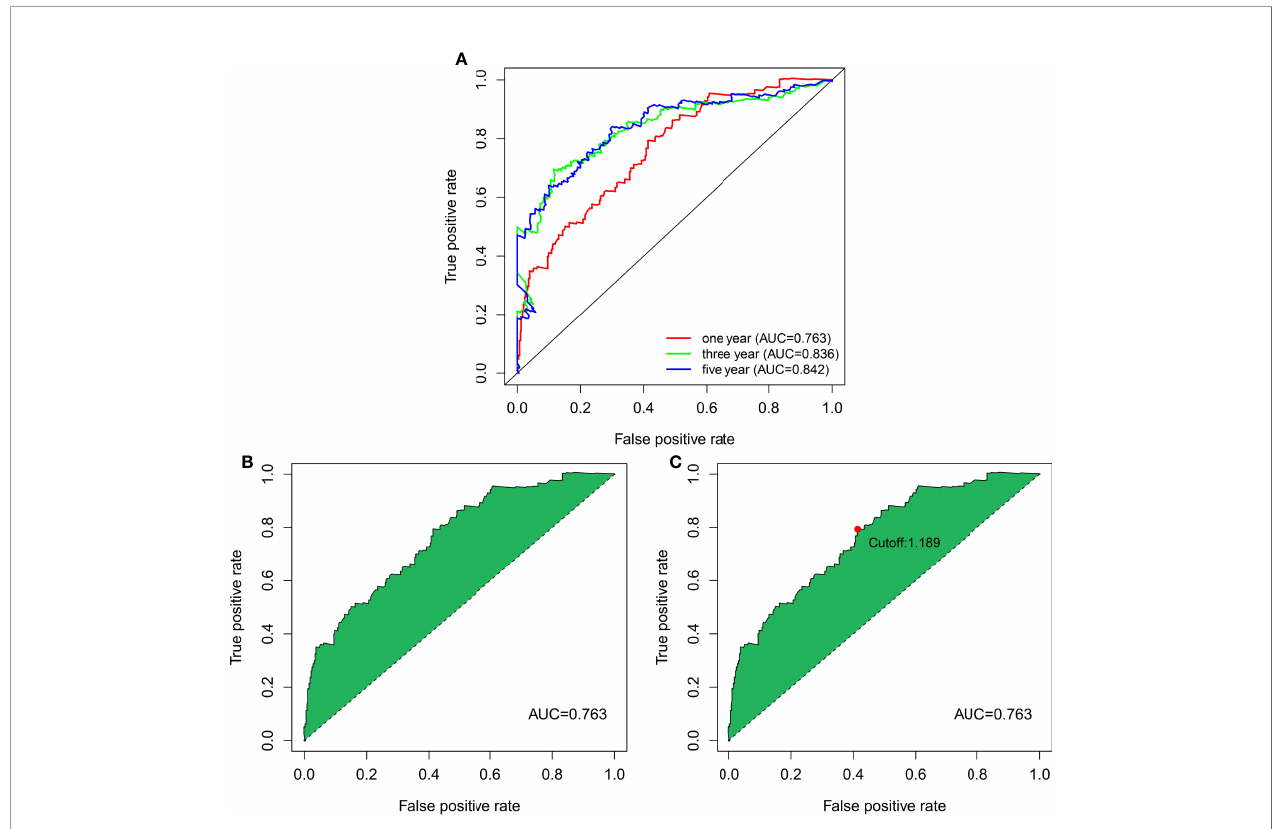
FIGURE 3 | DEnrlncRNA pairs to establish a risk assessment model. (A) The 1-, 3-, and 5-year ROC curves derived by optimal model construction showed that all AUC values were above 0.763. (B) The 1-year ROC curve with the largest AUC value generated by the model. (C) The cutoff value of 1.198 for distinguishing high- risk and low-risk patients was generated using the optimal